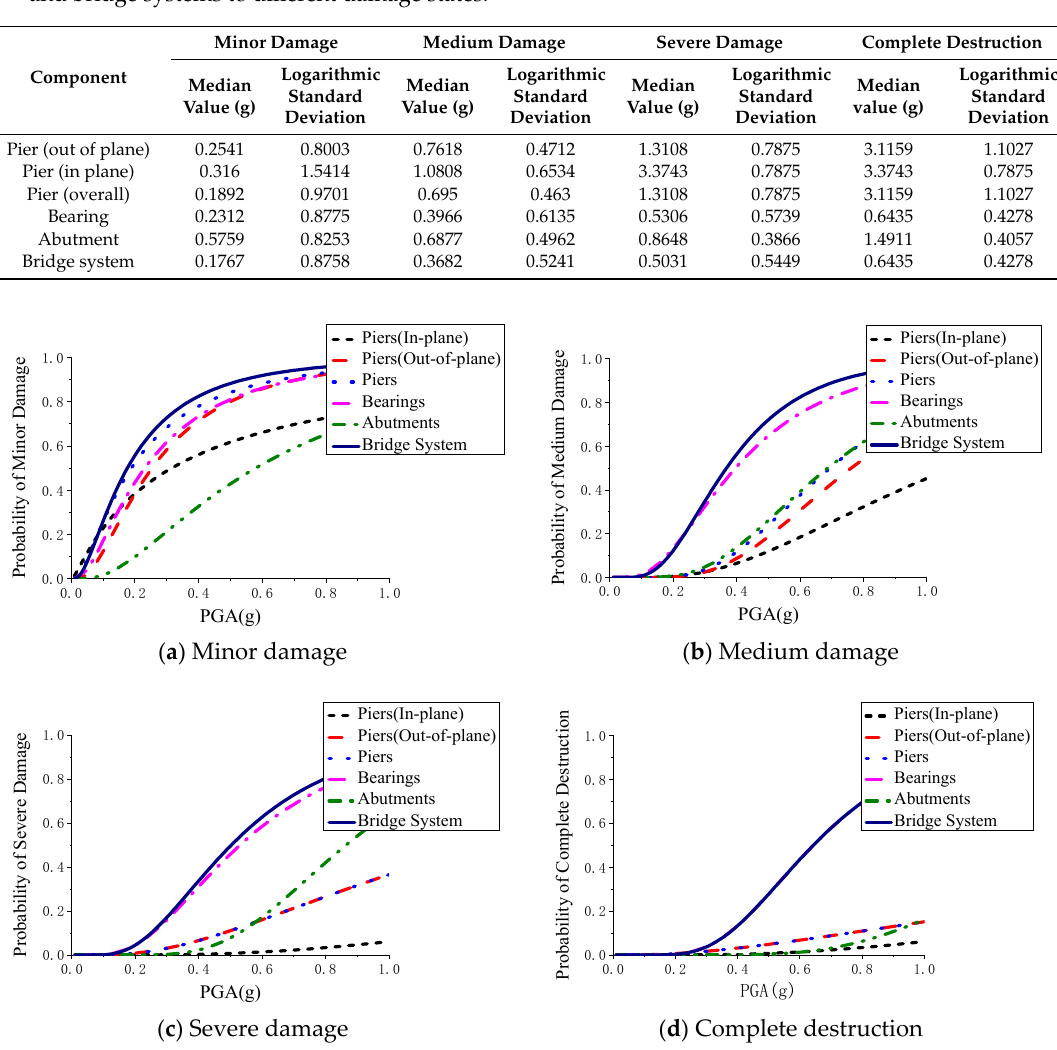
Figure 9. Seismic fragility curves of the bridges.